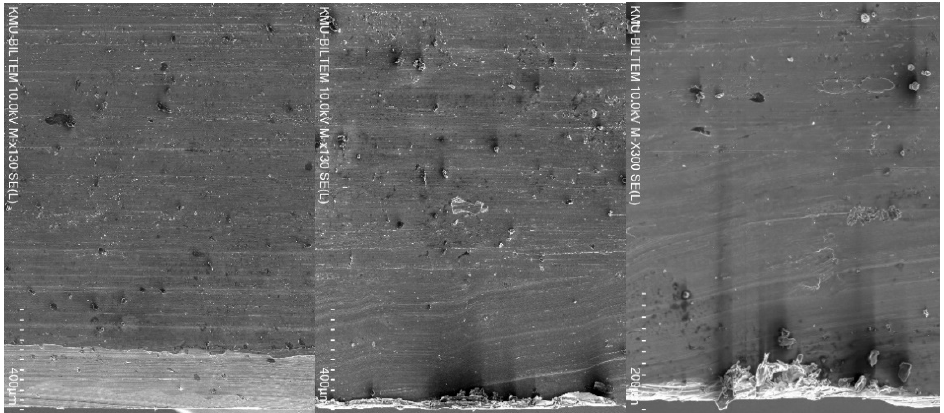
Figure 12. Hole condition at the exit showing edge quality and burr formation for holes drilled at n = 3000 rpm and f = 50 mm/min (From left to right: using TiN/TiAlN, TiAlN and TiN coating).